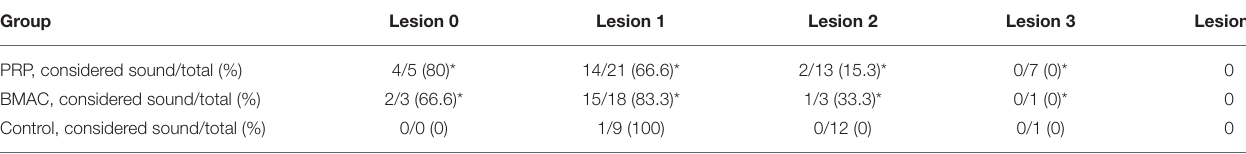
TABLE 2 | Ultrasound scores among the groups at T1.